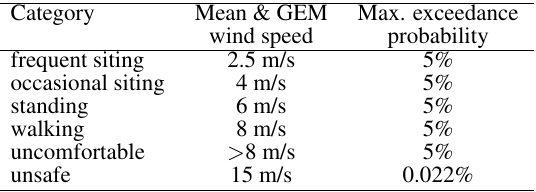
Table 2. Wind comfort categories, simplified from (of London Corporation, 2019). GEM: Gust equivalent mean Using this wind comfort we created Figure 7, where the results at 1.75 m height are plotted in function of the pedestrian com- fort classification. Considering that the inflow velocity mag- nitude was set to 4.9 m/s it is expected not to retrieve sections of the urban area within the highest wind speed classifications.